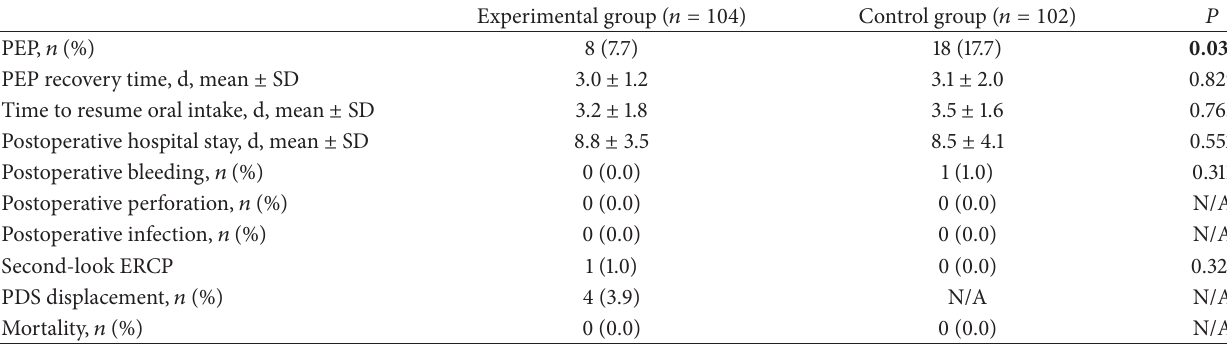
Table 3: PEP and other ERCP-associated